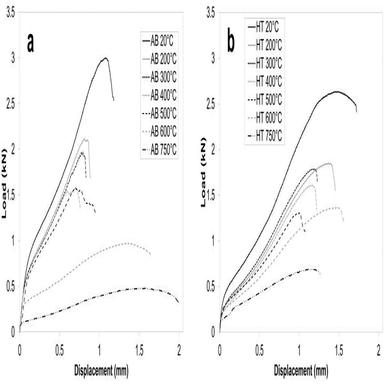
SP load-displacement responses for LPBF DSS 2205 in the (a) as-built and (b) heat-treated conditions.